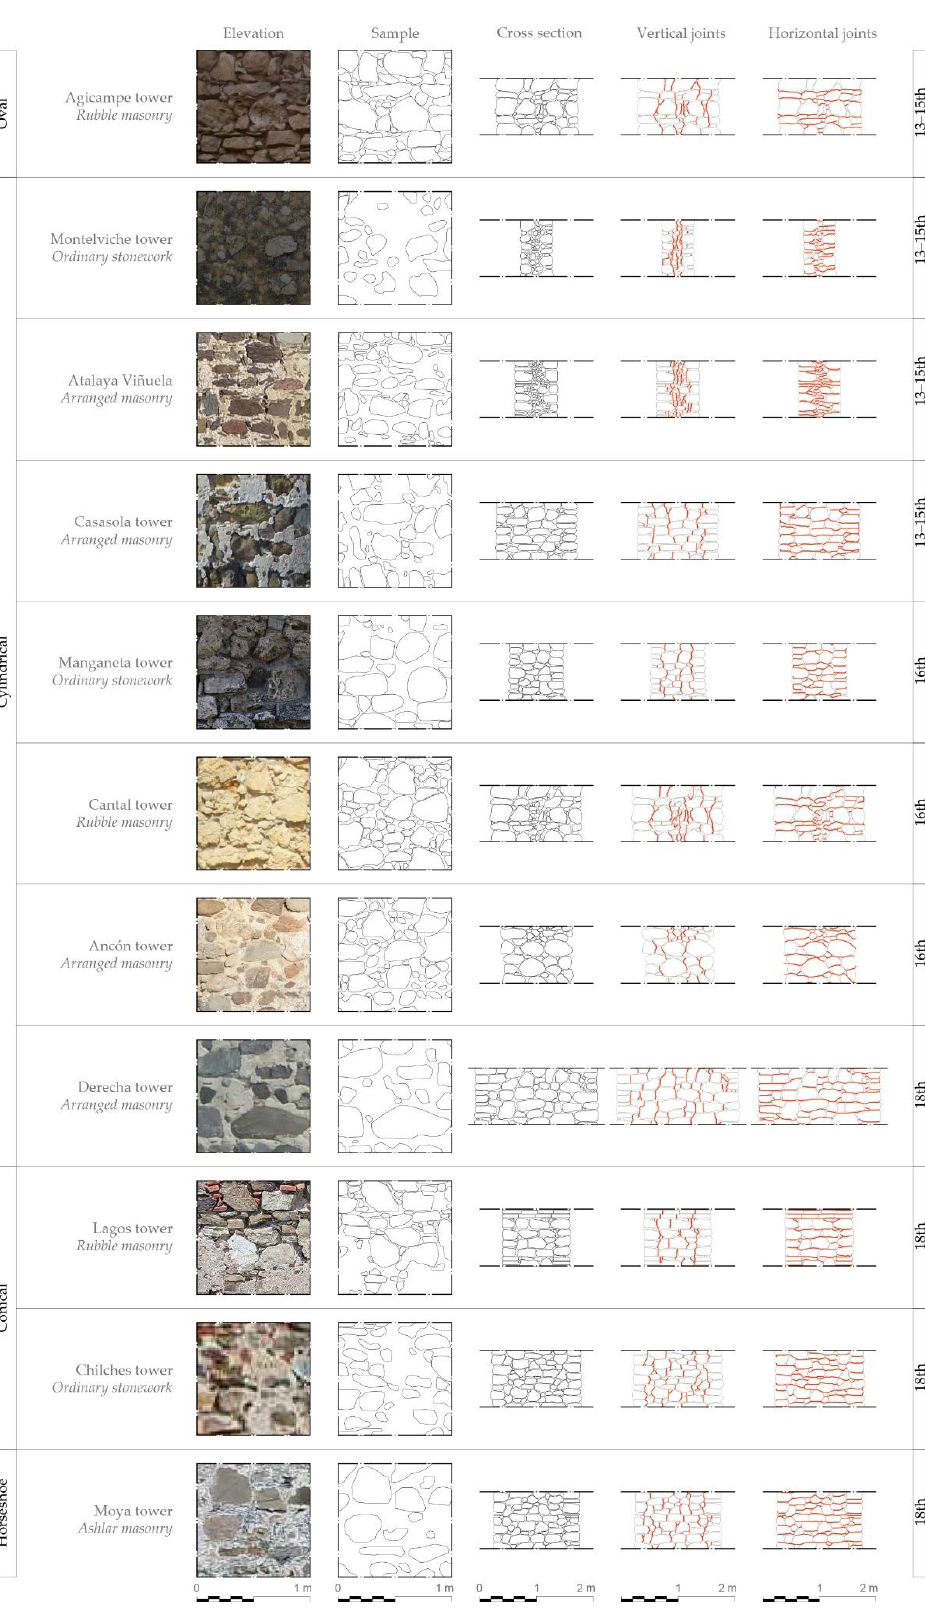
Figure 8. Description of wall construction features in the various towers under study: oval, cylindrical, conical and horseshoe-shaped.